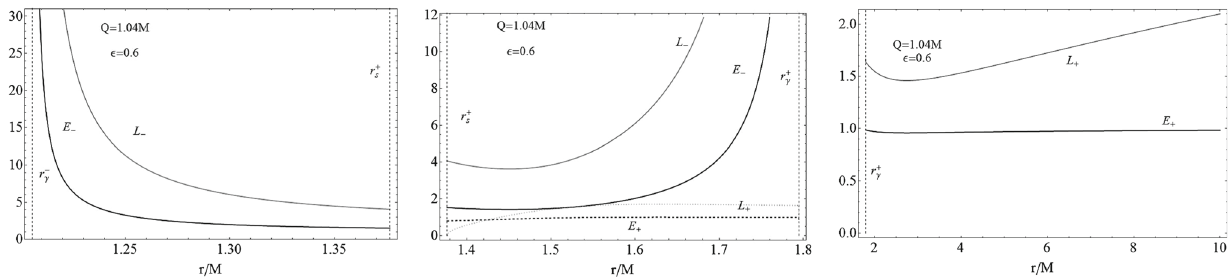
√ √ Fig. 15 Class : 5 /( 2 6 ) M < Q < ( 3 6 / 7 ) M and (cid:2) l ≤ (cid:2) ≤ (cid:9)(cid:9) (cid:2) + . ( gray curve ) and energy E = E + ( black curve ) in r − γ < r < r + s ( left Parameter choice is as follows: Q = 1 . 04 M and (cid:2) = 0 . 6. Then (cid:9)(cid:9) (cid:2) + = plot ); l = L ± in r + s ≤ r < r + γ ( center plot ); and L = L − in r ≥ r + γ 0 . 811927 and (cid:2) l = 0 . 566574, r + s = 1 . 37651 M , r − γ = 1 . 20538 M , and r + γ = 1 . 79462 M .Circularorbitsexistwithangularmomentum L = L +